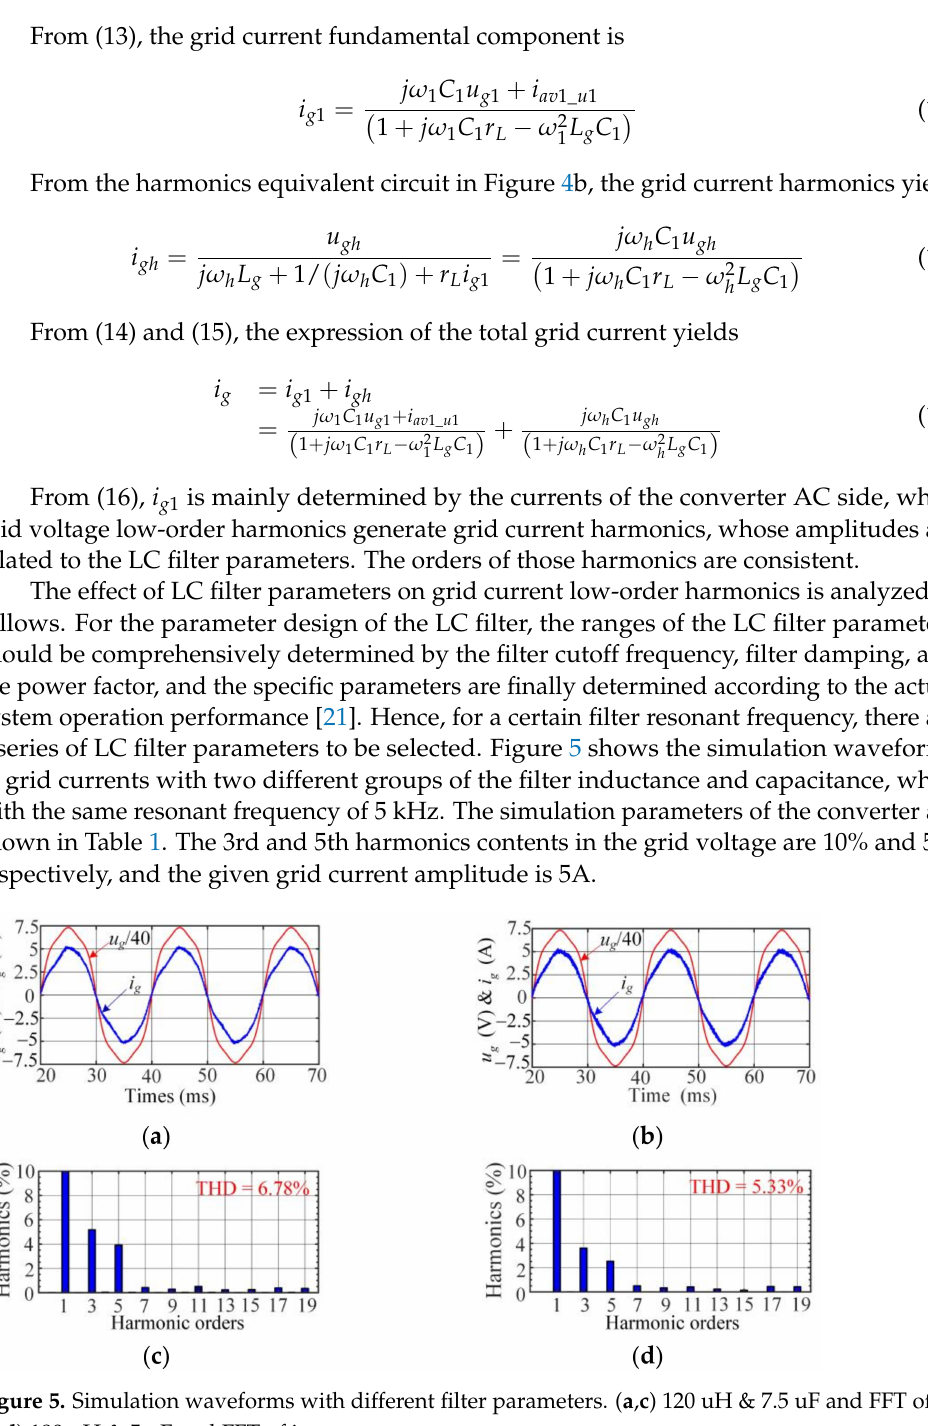
Figure 4. AC side equivalent circuits of Q1S AC-DC converter. ( a ) The fundamental equivalent circuit, ( b ) the harmonic equivalent circuit.